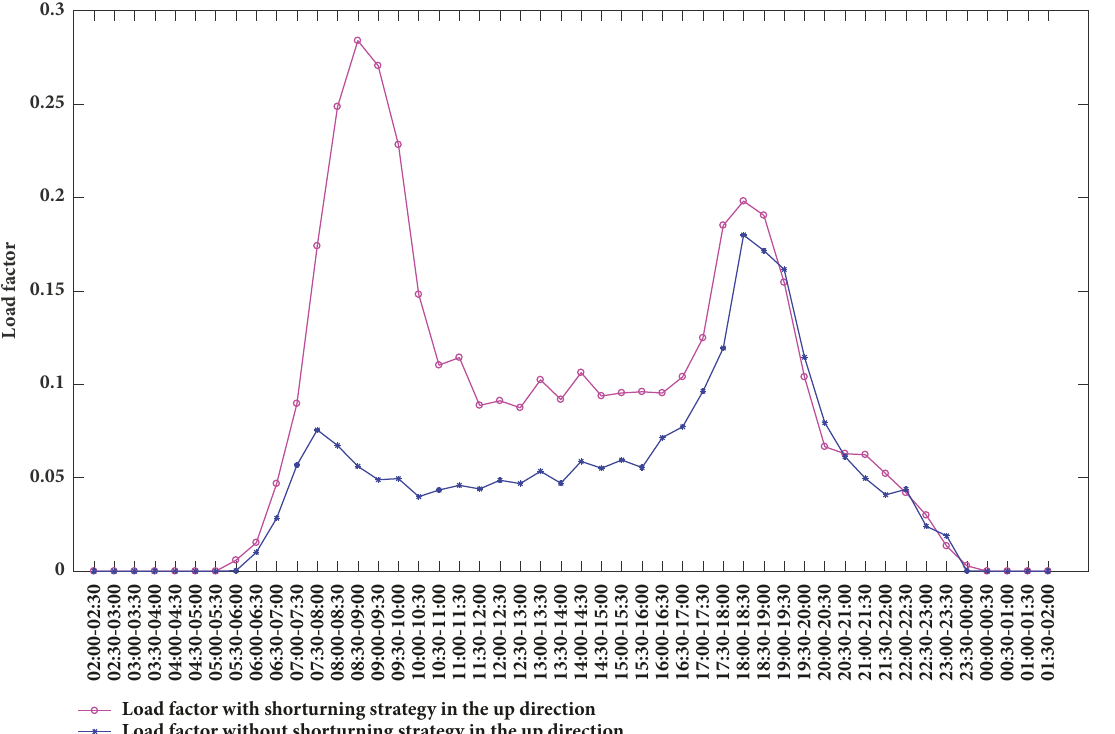
Figure 13: Load factor of a train service at Qingyuan Road Station.